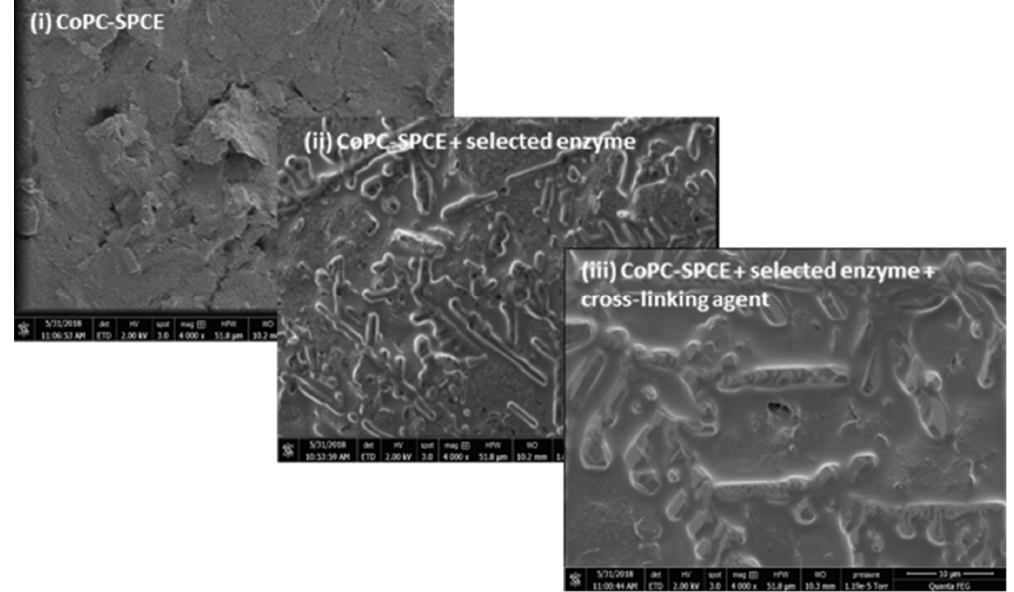
Figure 4. Scanning electron microscopy images obtained of the working electrodes of: (i) initial cobalt phthalocyanine screen-printed carbon electrode (CoPC-SPCE); (ii) CoPC-SPCE with lipoxygenase (LOX) deposited on the surface; (iii) CoPC-SPCE with LOX and glutaraldehyde deposited on the surface.